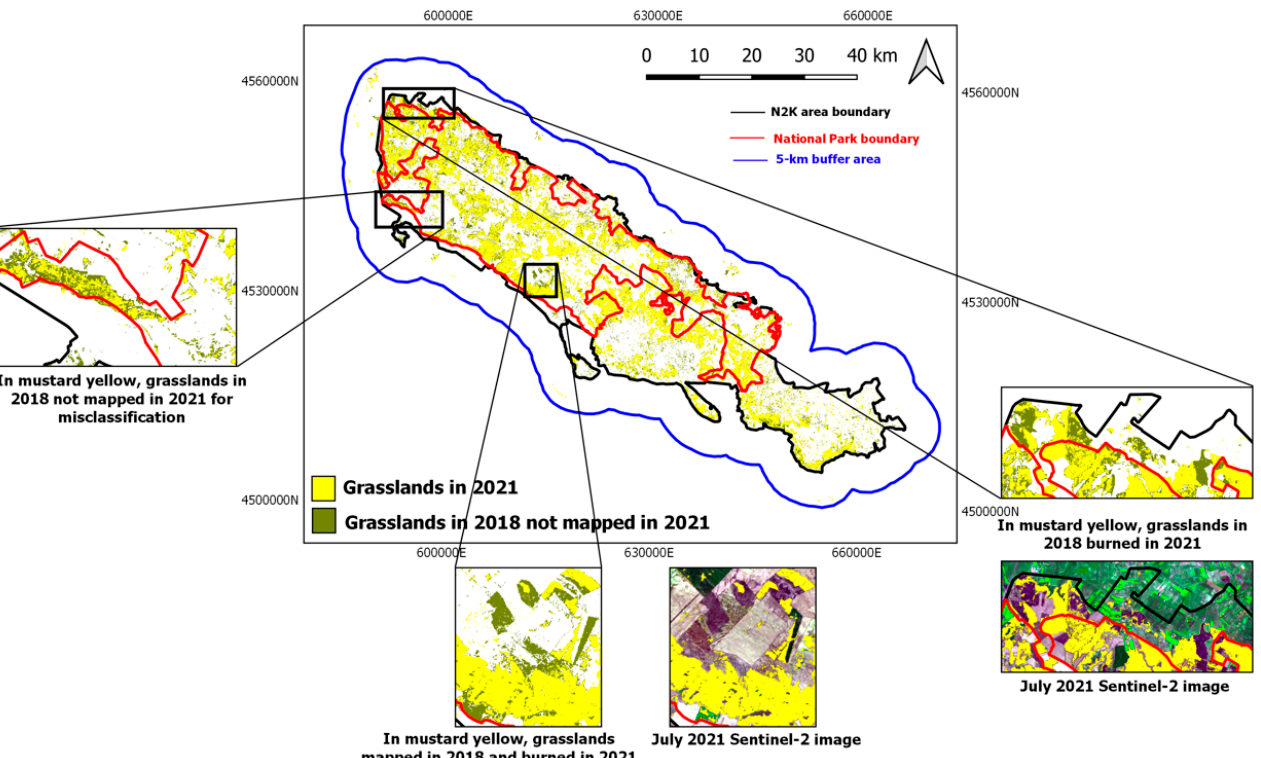
Figure 13. Grasslands mapping for 2021 overlapped on that for 2018: grasslands regrowth areas highlighted in mustard yellow. In the close-up on the left an example of misclassification is shown and the other close-ups report recent burn